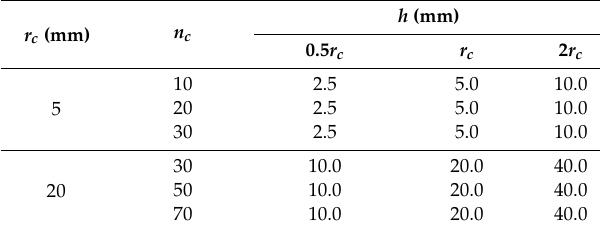
Table 1. Geometrical parameters for considered cases.